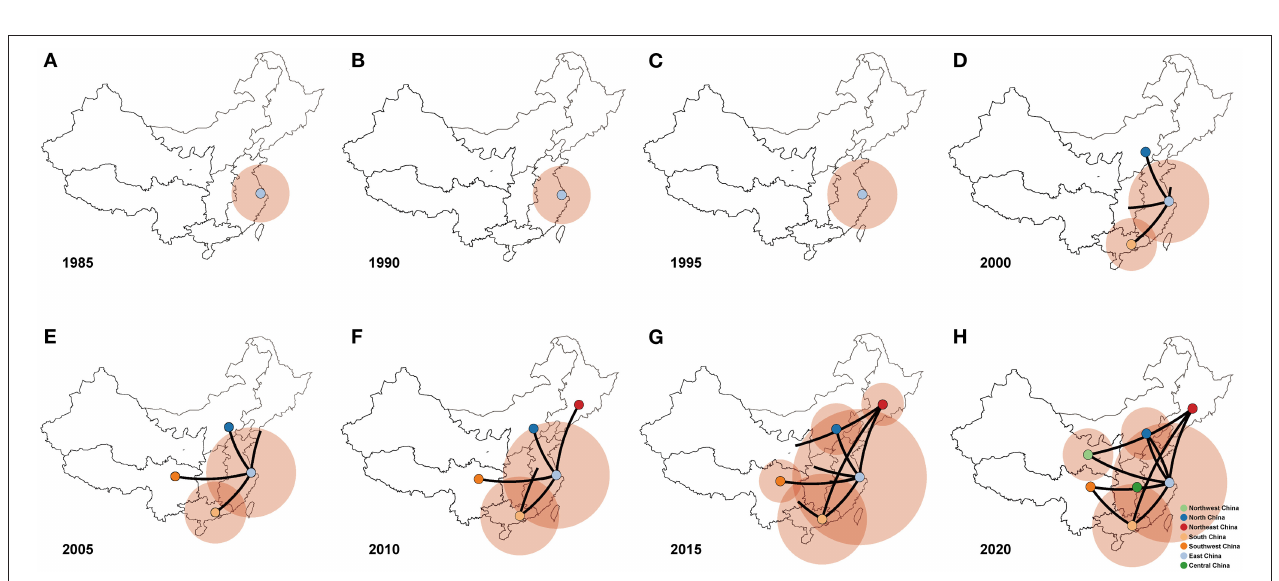
FIGURE 6 | Spatiotemporal dynamics of PPMV-1 isolates among different regions in China represented with snapshots of the dispersal pattern for (A) 1985, (B) 1990, (C) 1995, (D) 2000, (E) 2005, (F) 2010, (G) 2015, and (H) 2020.